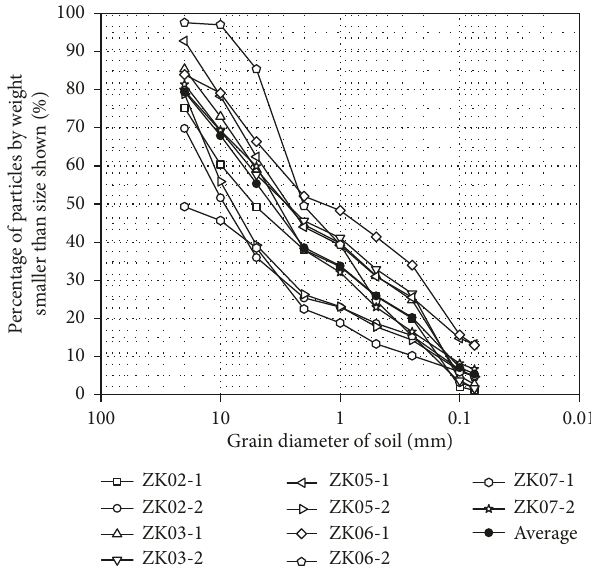
Figure 6: Grading analysis curve of ten samples. Table 1: Particle composition of the ten samples. Name of the